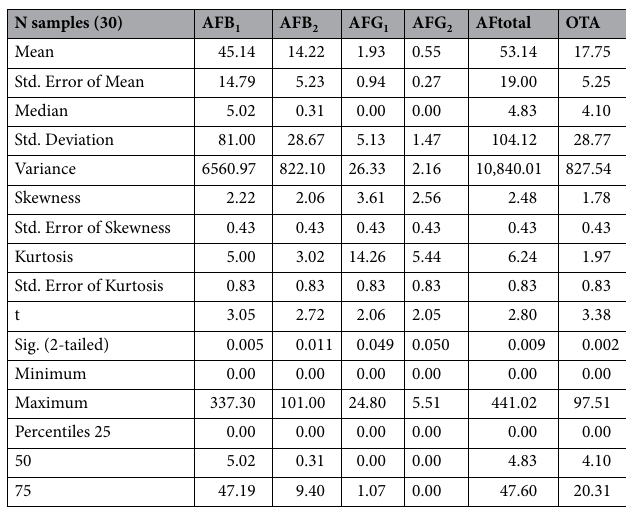
Table 9. Statistical summary of data obtained from the Eastern Region of Ghana.